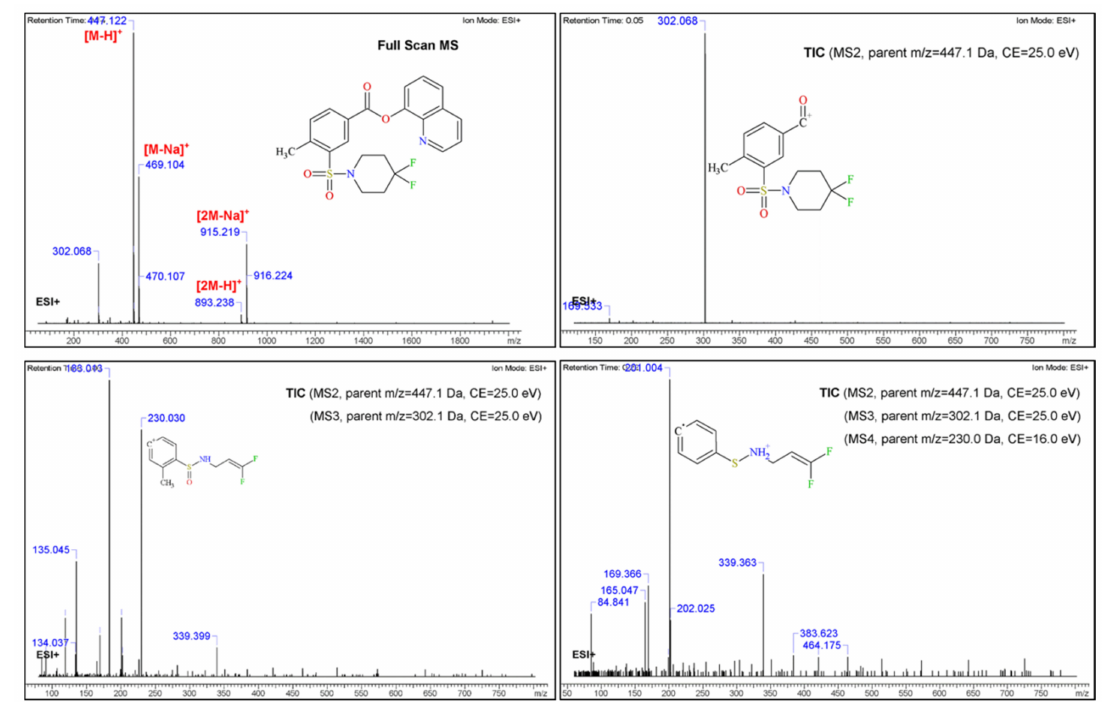
Figure 6. Flow injection Orbitrap MS and MS E spectra of the target analyte